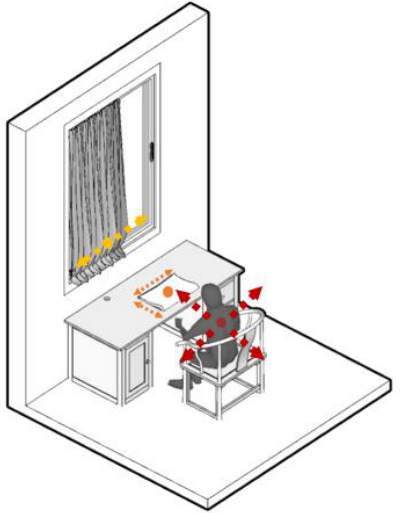
Figure 5. Adjustable position.